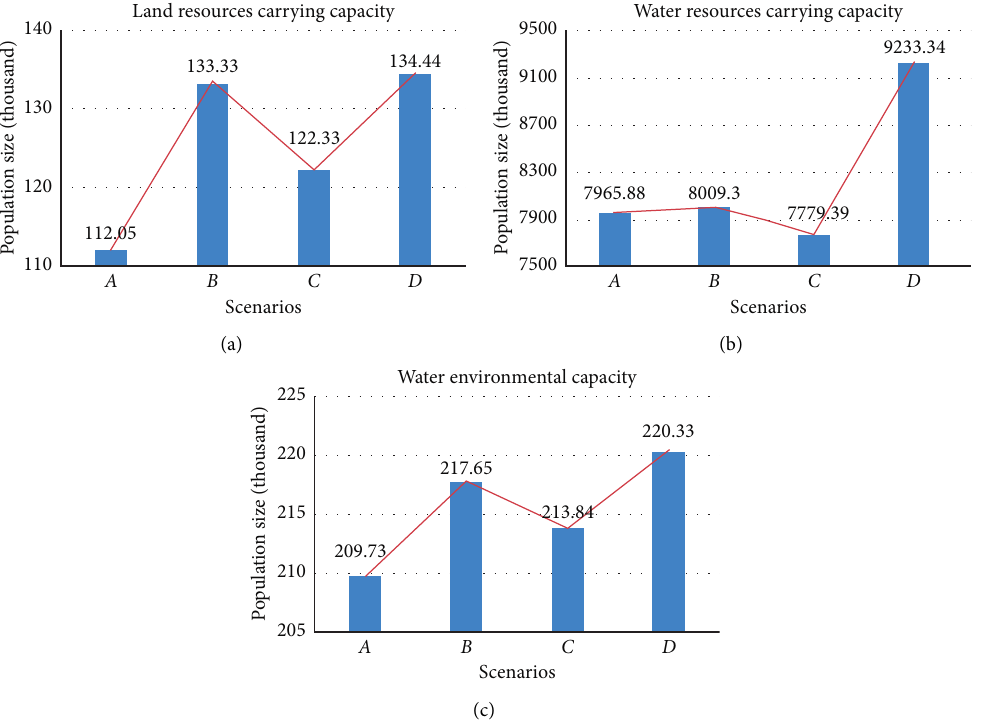
Figure 4: Comparison of the RECC under different scenarios in Jingjiang.